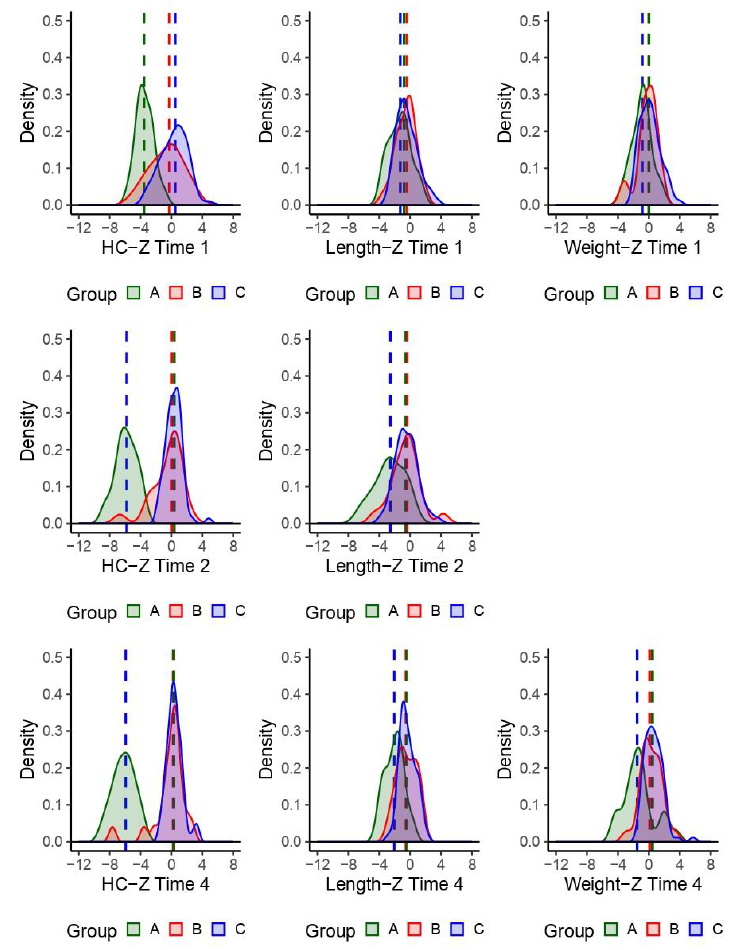
Figure 2. Density plots of observed children’s head circumferences (HC), length, and weight z -scores. Time 1: birth; time 2: age 1 − 7 months; time 4: age approximately 24 months. Group phenotype: A = Zika-specific, B = nonspecific dysmorphic, and C =